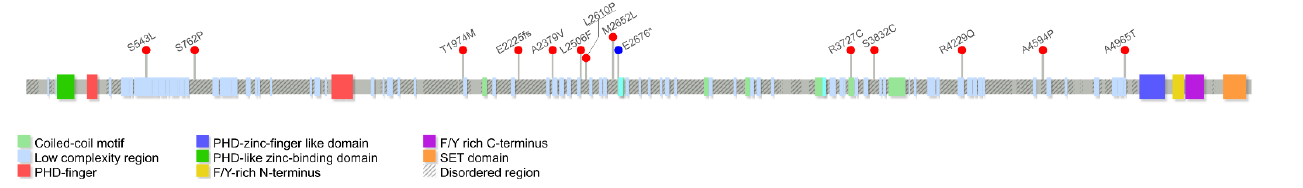
Figure 5. Distribution of the KMT2C mutations detected in this study, along the gene. In our study, mutations in the KMT2D and KMT2C were significantly rarely com- bined in one sample ( p = 0.038). There is a hypothesis that mutually exclusive genomic events are functionally related by common biological pathways, and mutually exclusive genes act on the same downstream effectors, thereby demonstrating functional redun- dancy. Therefore, the aberration of one of these genes is enough to completely disrupt their common pathways [24]. The KMT2D and KMT2C are components of similar COM- PASS complexes that perform the same function. Deregulation of either KMT2C or KMT2D separately can serve as a driver mutation at the early stages of carcinogenesis, leading to changes in the epigenomic landscape. As was demonstrated for bladder cancer, tumor cells with low KMT2C activity experienced a deficiency of DNA repair mediated